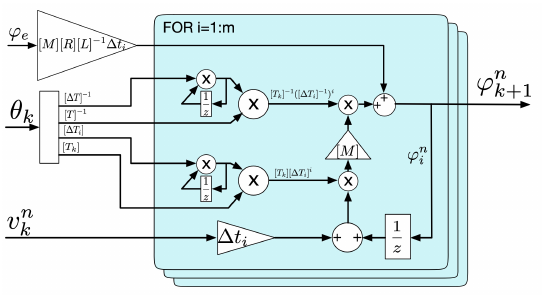
Figure A1. Discrete time model using the algorithm under study without optimization and PM flux: NAT-DSCR.